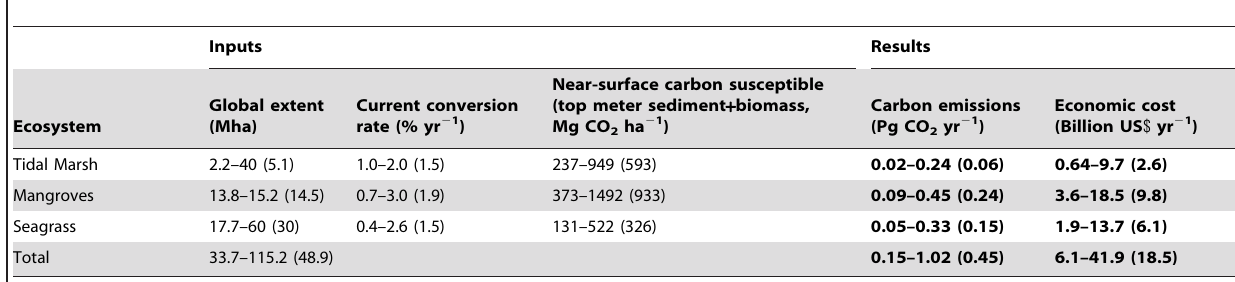
Table 1. Estimates of carbon released by land-use change in coastal ecosystems globally and associated economic